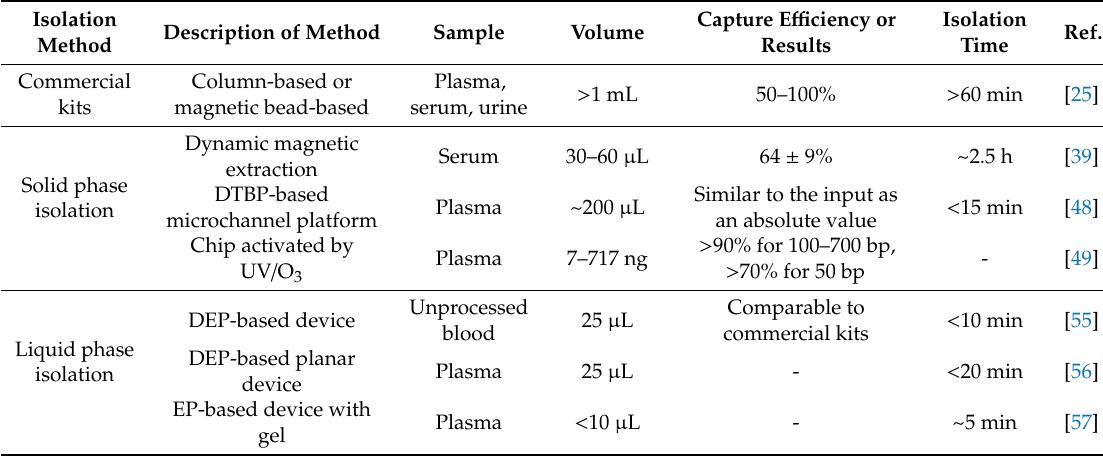
Figure 4. The DEP-based microarray device and scheme for isolation of cfDNA from blood. Reproduced with permission from [55] . ( A ) AC electrokinetic microarray device used with an expanded view of the device materials composition. ( B ) Microarray with whole blood (red) containing fluorescent DNA (green). ( C ) Application of the AC electric field causing the fluorescent DNA (green) to be concentrated in the DEP high-field regions on the microelectrodes, while the blood cells (red) move into the DEP low-field regions between the microelectrodes. ( D ) A fluidic wash removes the blood cells from the microarray under the AC field while DNA remains concentrated in the DEP high-field regions. Table 1. Summary of cfDNA isolation techniques.